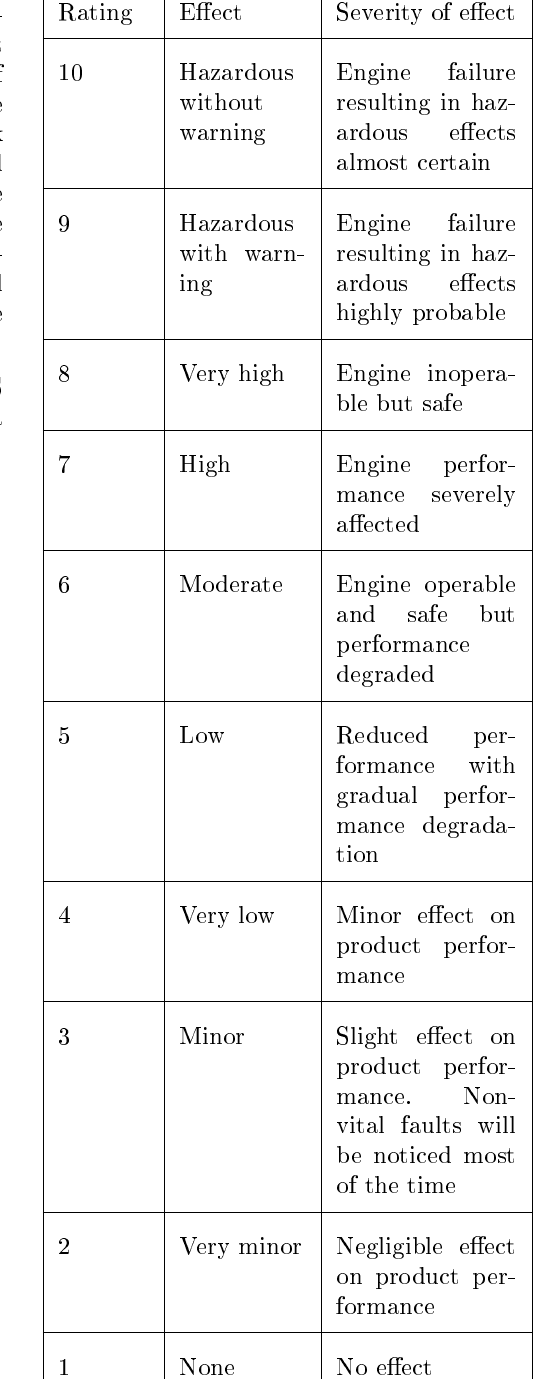
Tab. 2: Consequences of failure rating